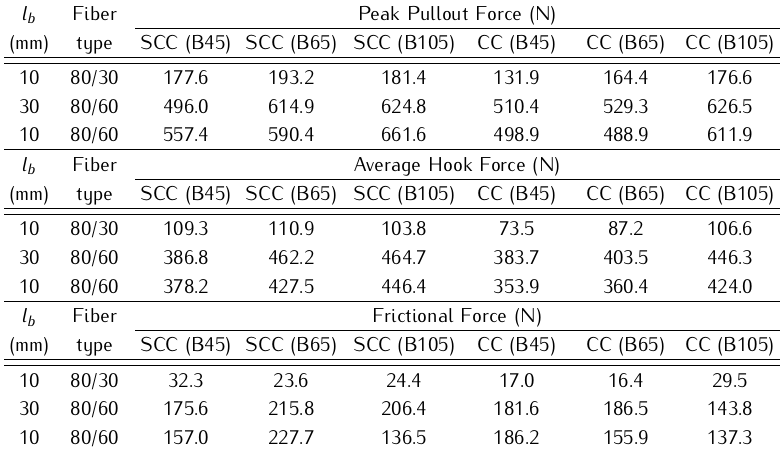
Table 2. Experimental results from the Grünewald